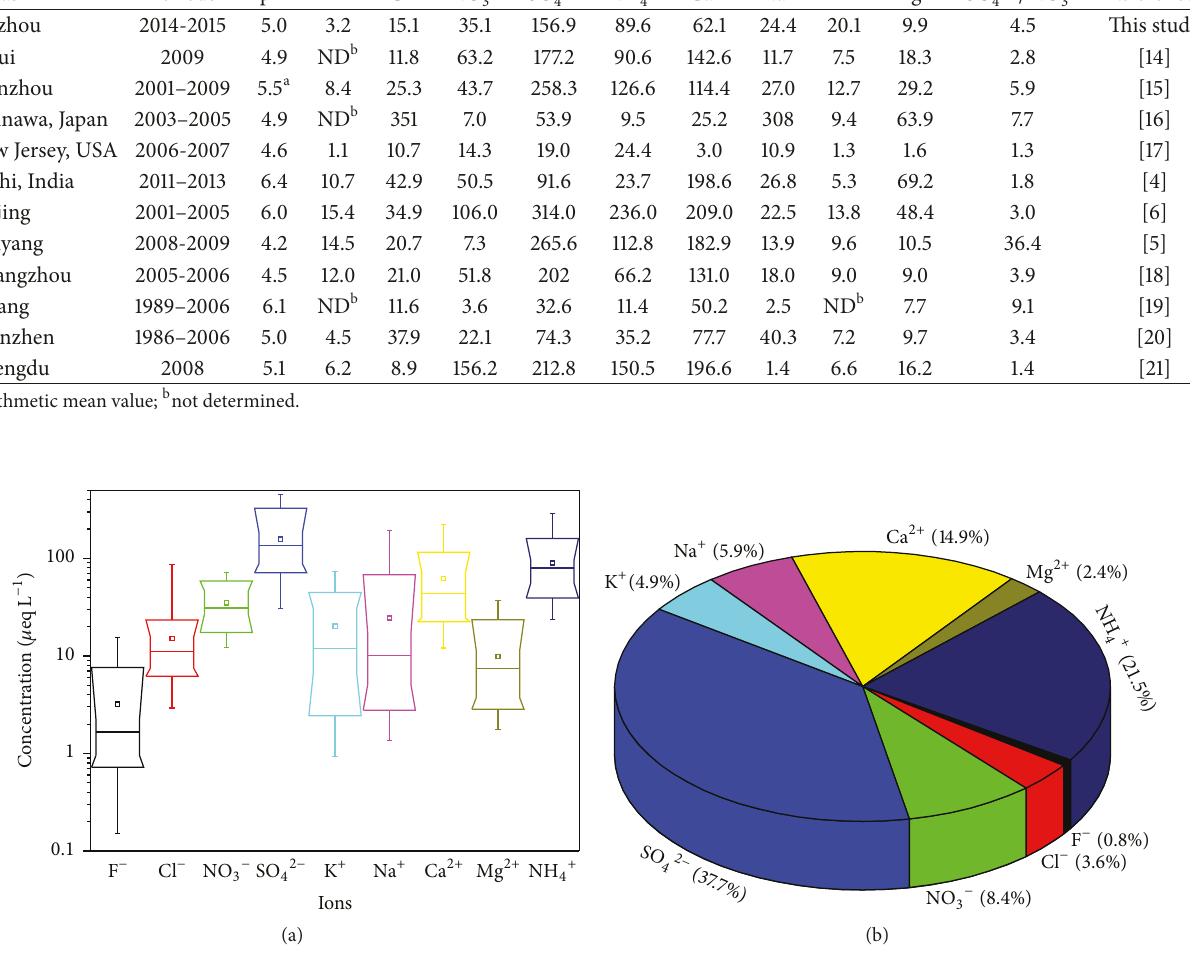
Table 1: VWM concentrations of major inorganic ions in the precipitation in Wanzhou and some selected areas (unit: 𝜇 eq L −1 ). Areas